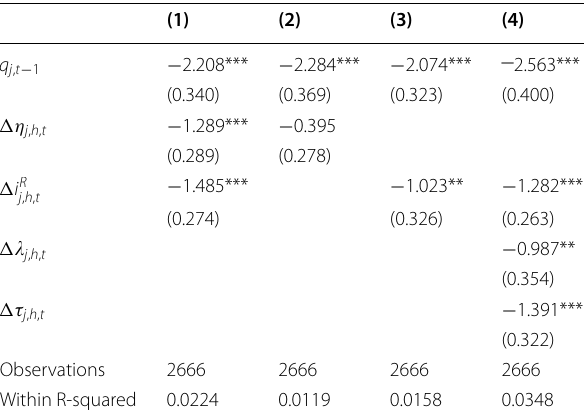
Table 2 The Effect of Convenience Yields on Bilateral Exchange